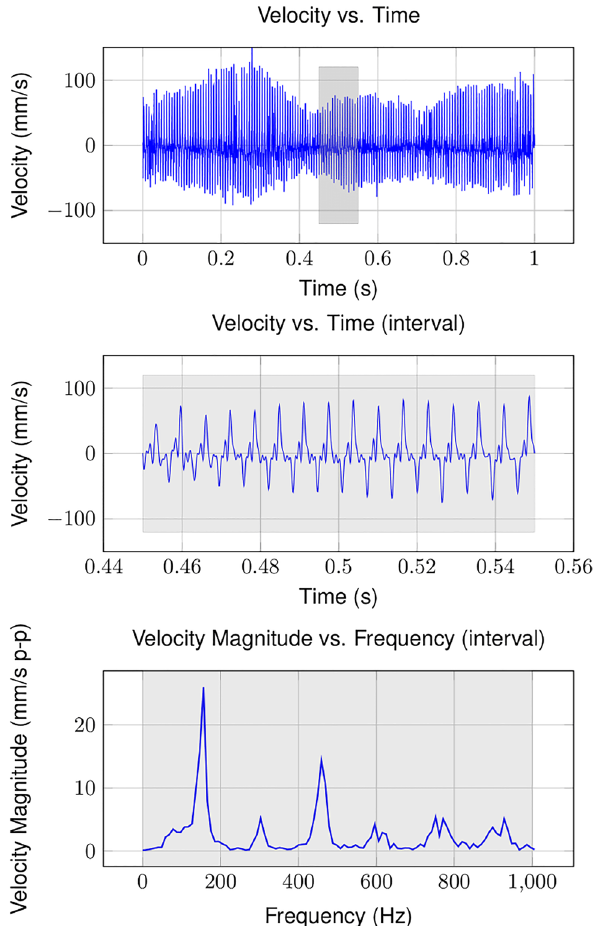
Figure 3. Representative velocity measurements. (Top) Time series data over one second of continuous buzzing. (Middle) Individual interval from which thorax kinematics and force values are calculated. (Bottom) FFT magnitude of interval data. Thorax oscillation frequency is estimated from each velocity interval FFT. Note the frequency harmonics superimposed on the fundamental oscillation